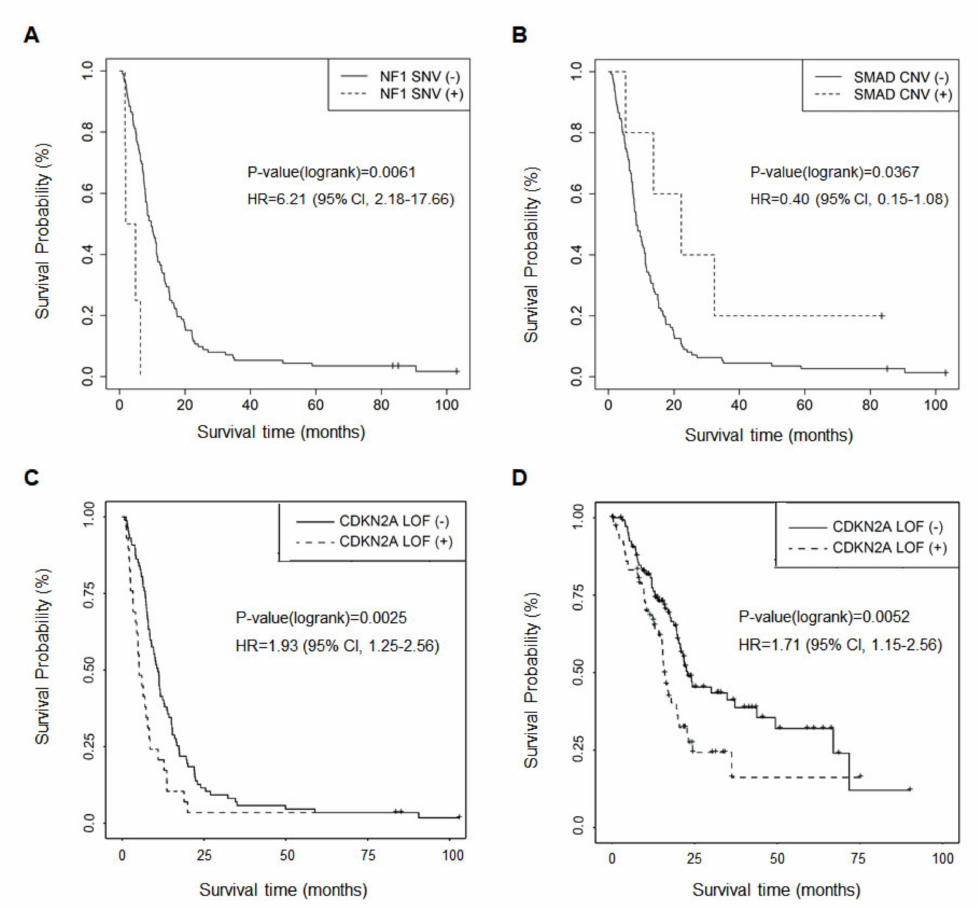
Figure 5. Kaplan—Meier plots for genetic alterations significantly associated with survival. The Kaplan–Meier plots indicate genes significantly ( p < 0.05) associated with the survival of patients with pancreatic ductal adenocarcinoma (PDAC). ( A ) Single nucleotide variant (SNV) of NF1 ( p = 0.0061), ( B ) copy number variation (CNV) of SMAD4 ( p = 0.0367), and ( C ) loss-of-function (LOF) mutation of CDKN2A ( p = 0.0025) were related to survival in PDAC. ( D ) LOF mutation of CDKN2A and worse prognosis was verified by TCGA